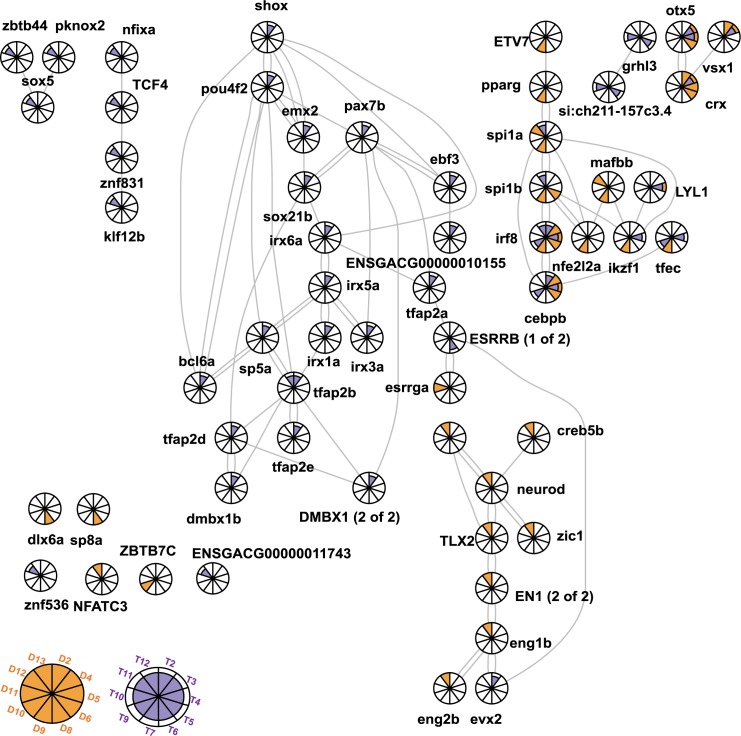
Network of interacting transcription factors (TFs) in the transcriptional regulatory network highlighting enrichments of TFs in clusters of DEGx.Each node represents a TF. Slices of pie correspond to different clusters in diencephalon or telencephalon; the key to the clusters is in the lower left corner. A full orange slice represents a diencephalon cluster. A purple half slice represents a telencephalon cluster, a purple and orange slice represents clusters in both brain regions. For example, cebpb is predicted to regulate D4, D5, D6, T3, T4, T9.